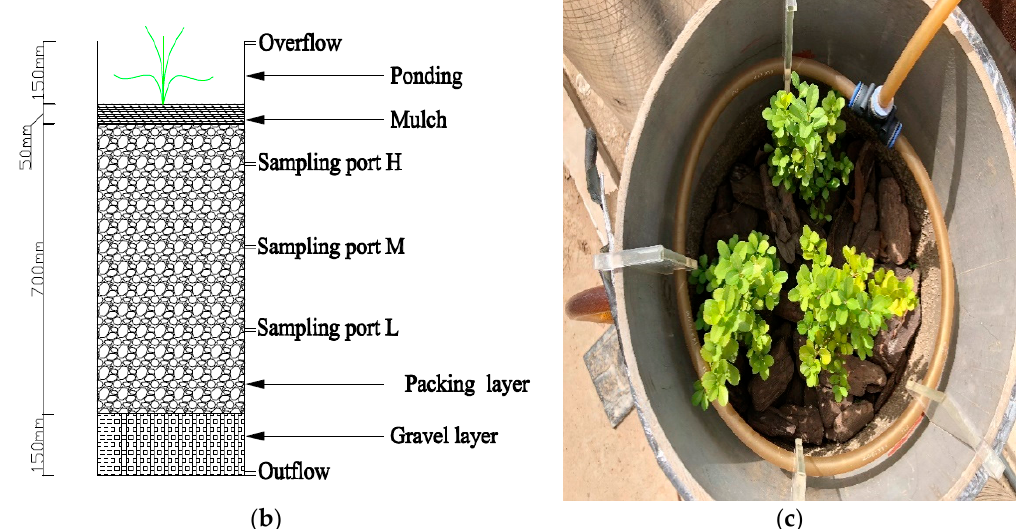
Figure 1. Schematic of the bioretention system; ( a ) sectional view; ( b ) partial site photos; ( c ) vertical view.